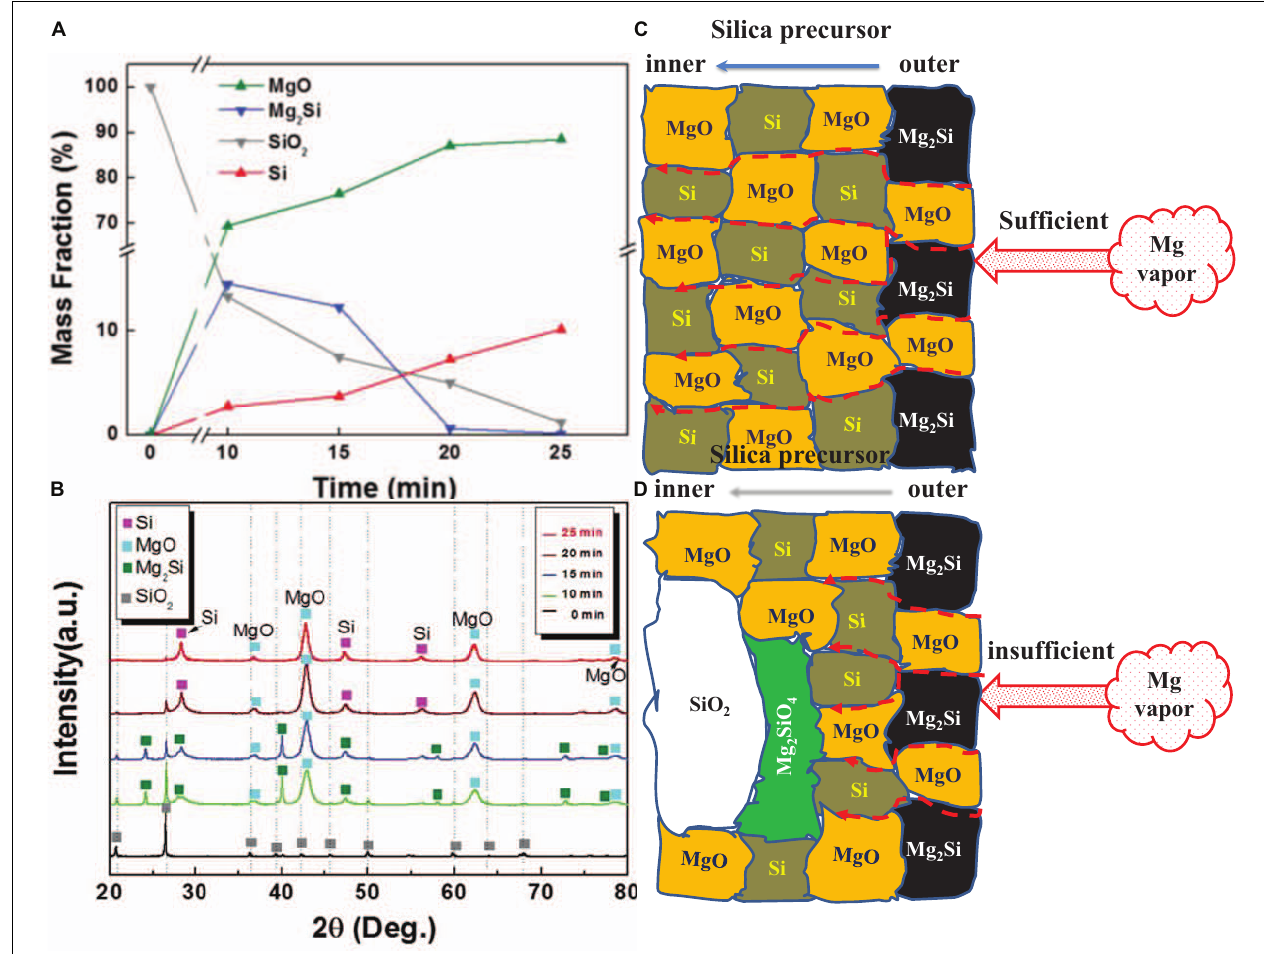
FIGURE 3 | XRD (A) and Changes in the product contents (B) with the reaction time, Reprinted from Ref. (Yoo et al., 2014), with the permission of John Wiley and Sons. (C,D) show the constitution of the products at different stages of the reduction